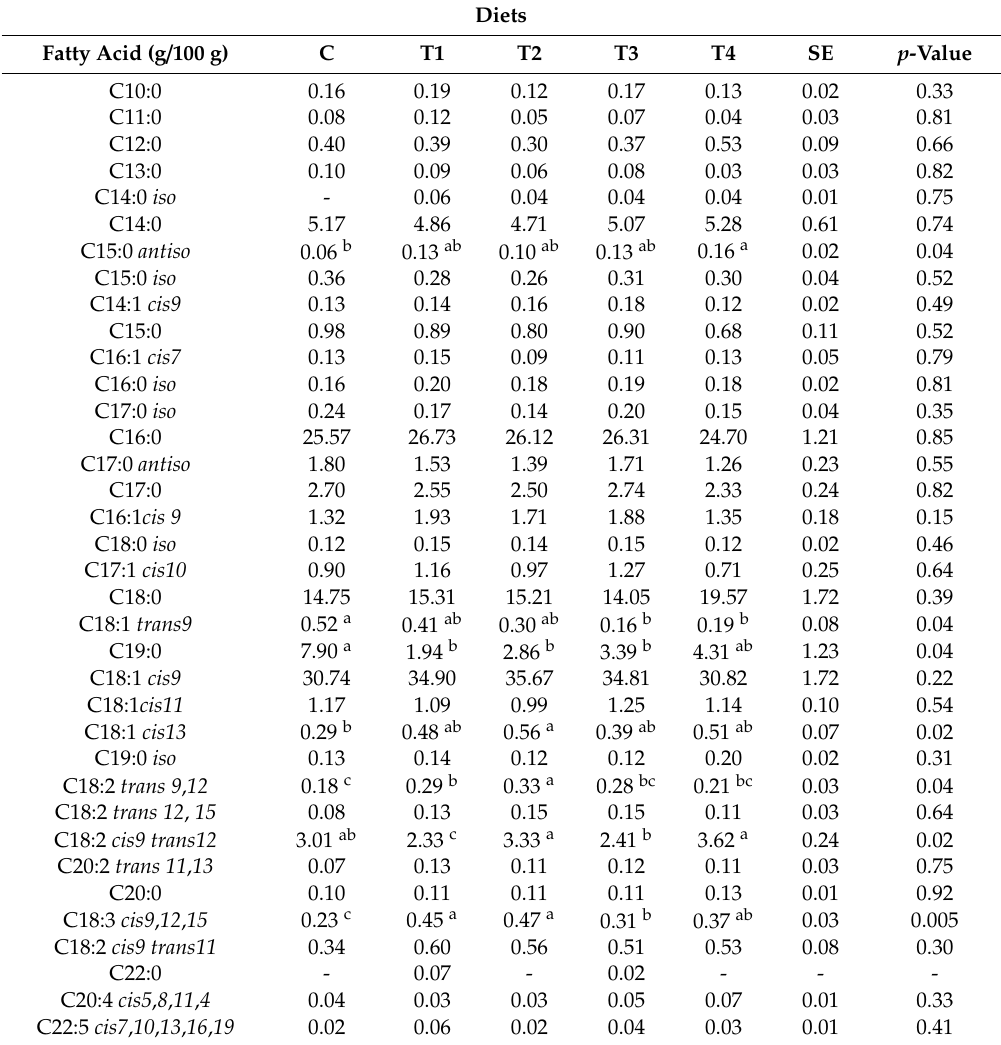
Table 4. Fatty acid profile of fat longissimus dorsi muscle fat from Naemi lambs (n = 4 per dietary group) fed di ff erent experimental